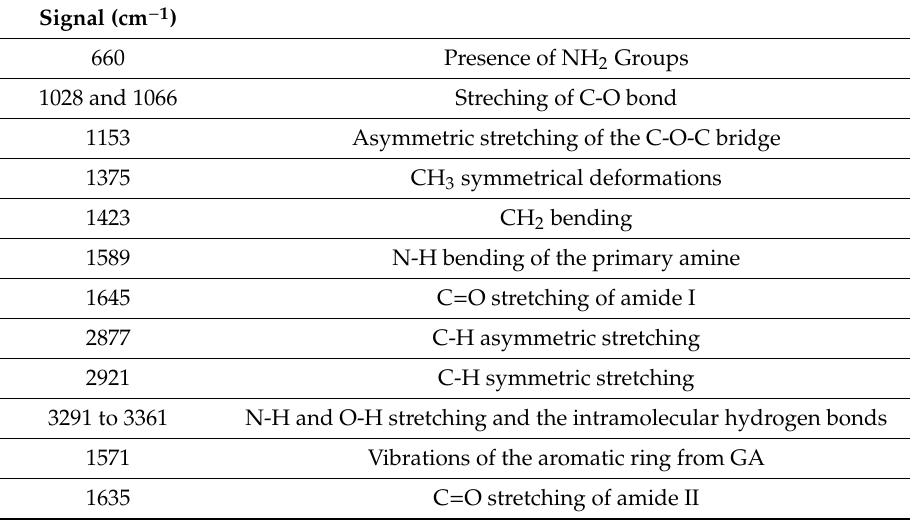
Table 1. Main bands observed on the FTIR spectra of unconjugated and conjugated